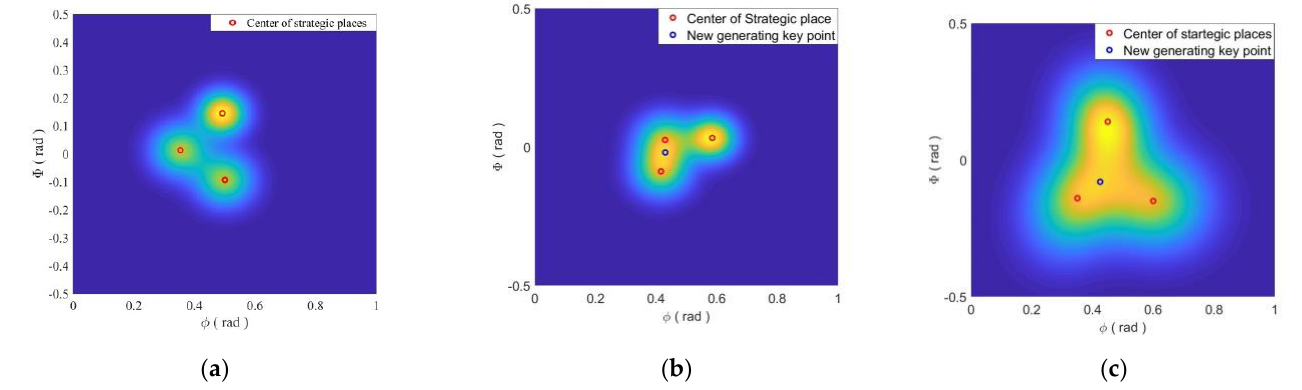
Figure 3. Effect of Importance map: ( a ) represents no generated key point; ( b ) means one key point is generated by two strategic places; and ( c ) means one key point is generated by all strategic places.